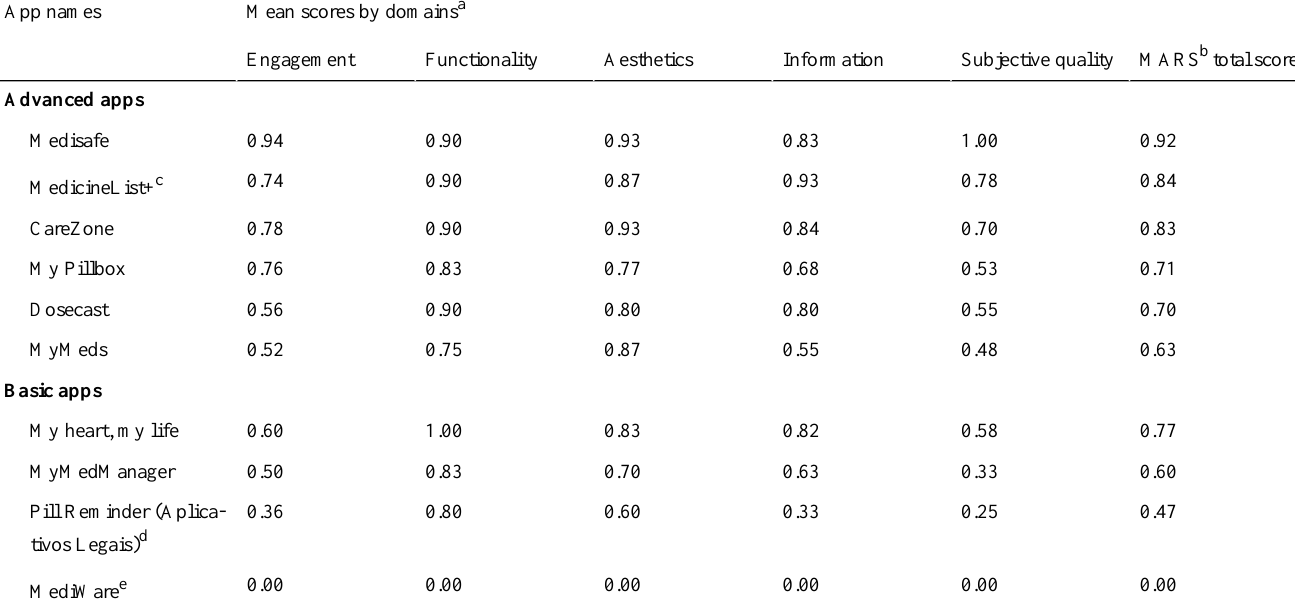
Mean scores by domains a App